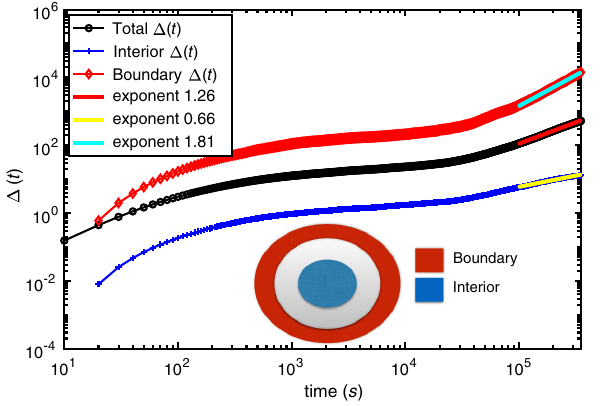
FIG. 13. The probability distribution P ( δ r ð t 2 Þ ) of cell displace- i 2 ¼ j r ð t 2 , in units of μ m 2 ] at δ t ¼ δ t Þ − r ð t ments [ δ r ð t i Þ i þ i Þj 100 s is shown. Cell trajectories until t ¼ 5 τ are analyzed at 2 τ ¼ 1 τ . The histogram was constructed by varying t in δ r ð t i i Þ min for over 400 cell trajectories and after obtaining approximately 2 . For comparison, the inset shows fits to 10 6 data points for δ r ð t i Þ both the exponential (dashed line) and power law (solid . min